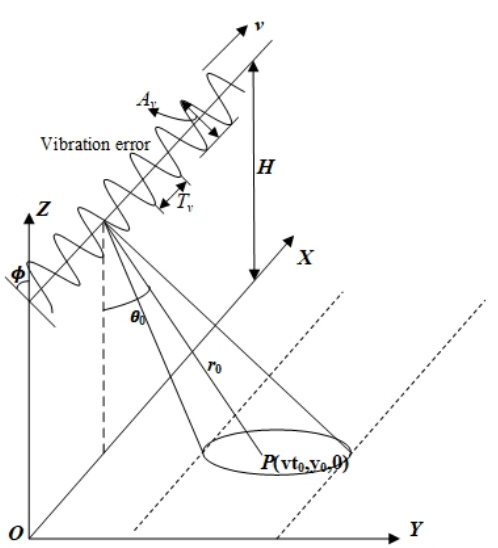
Figure 1. Terahertz synthetic aperture radar (THz-SAR) imaging geometry with high-frequency vibration